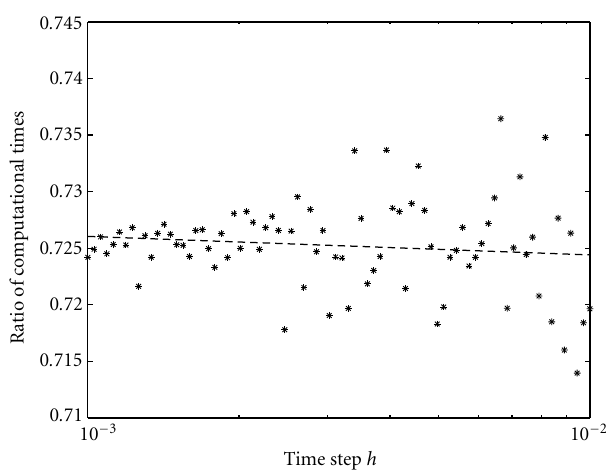
Figure 3.5. Ratio of computational time required for the accelerated RK3 scheme to that required for standard RK3 (see, [1]), showing an acceleration of at least 25% when the accelerated scheme is